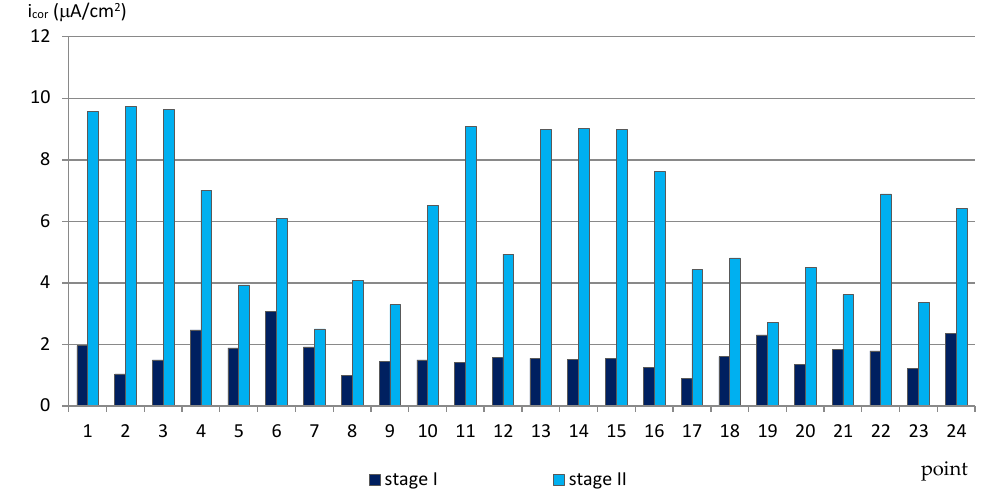
Figure 6. Corrosion current density measured on the reinforcement in C_III_n specimens.